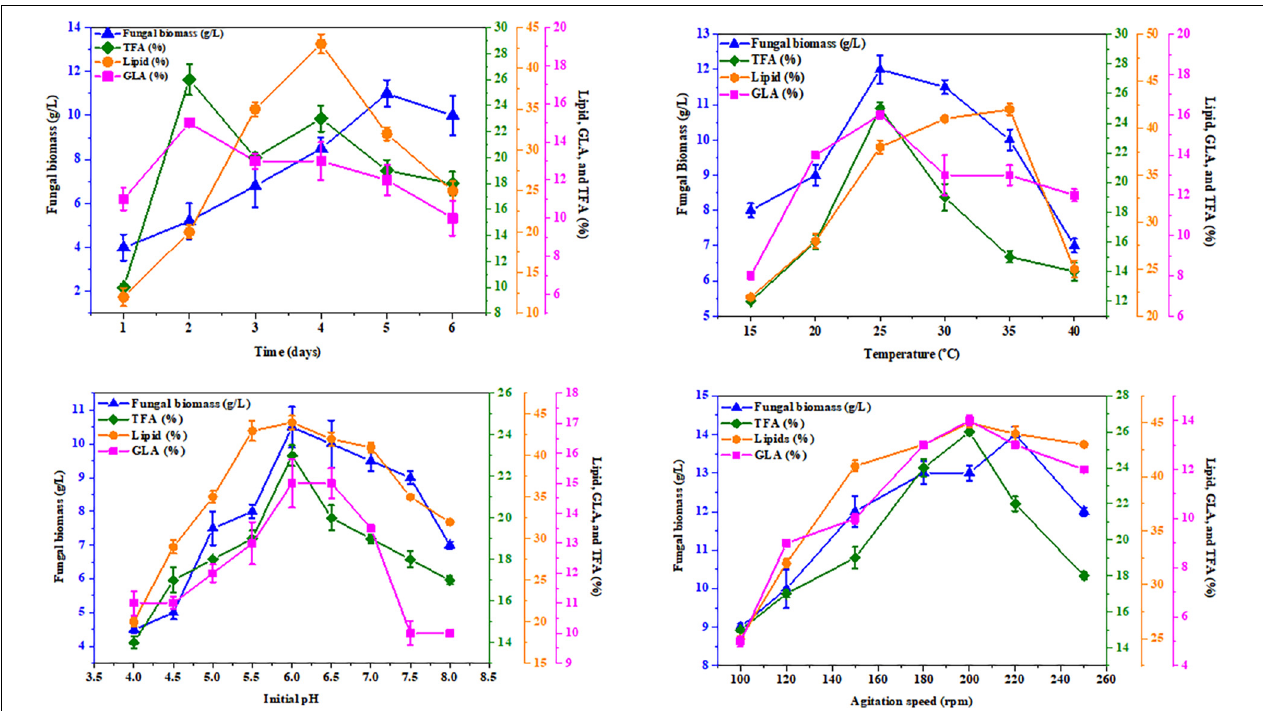
FIGURE 8 | Effect of fermentation time, temperature, initial pH, and agitation speed on the biomass, total lipids, GLA content, and TFAs in M. circinelloides AUMC 6696.A. Glutamine was employed as the nitrogen source. Error bars represent the average standard deviation from three biological replicates.